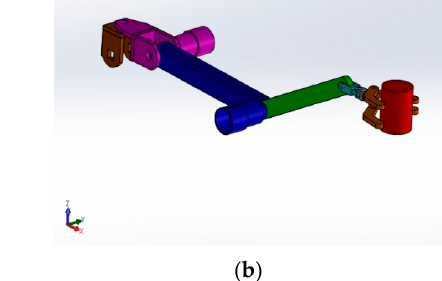
( c ) Figure 14. Reference images used for Table 2. ( a ) SET-8; ( b ) SET-11; ( c ) SET-12. Table 1. Experimental distance evaluation based on low-cost cameras’ vision. Images Set